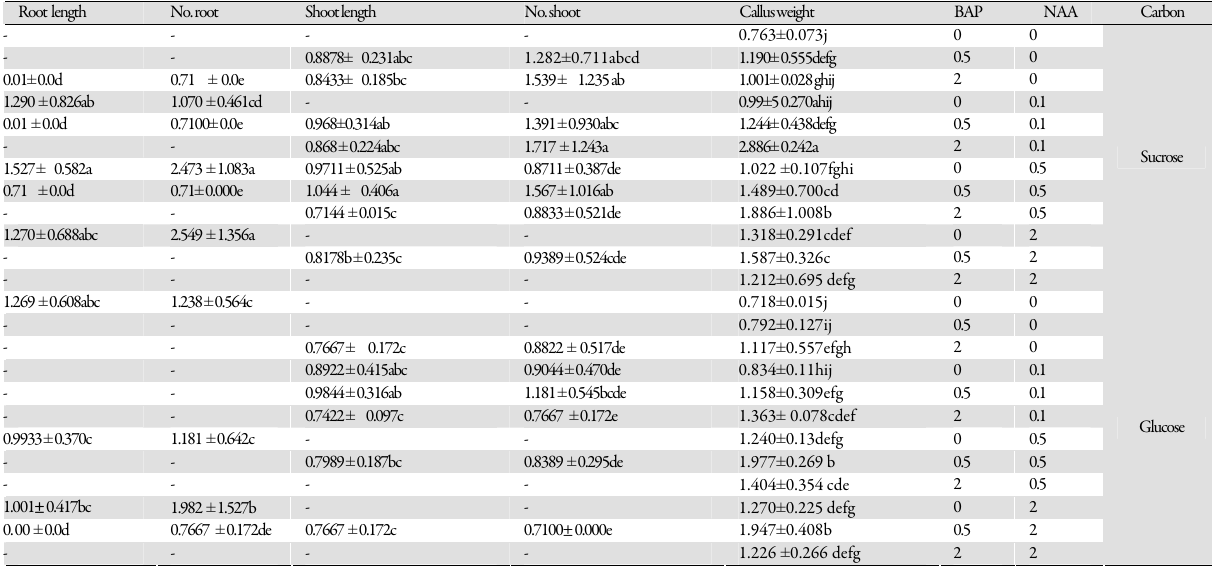
Table 10. The effect of interaction between growth regulators and carbon on callus, shoot and root induction of A . annua on MS medium Root length